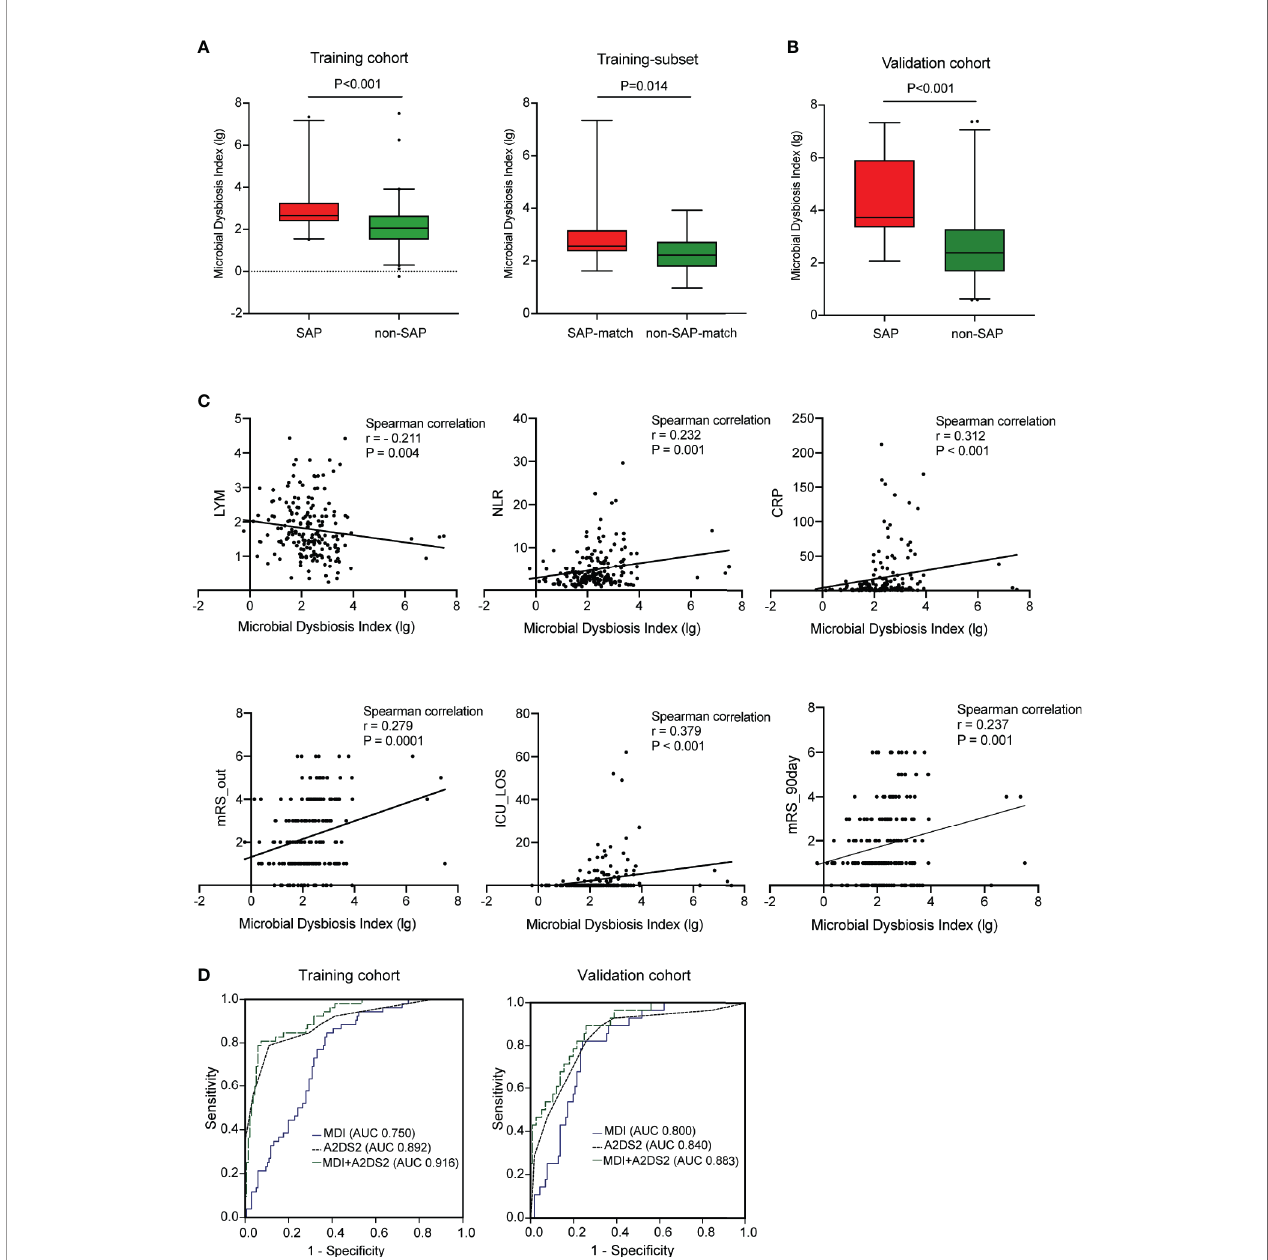
FIGURE 3 | Microbial dysbiosis is associated with SAP. (A) Box plot showing the MDI in the SAP and non-SAP groups in all patients ( A , left) and age- and NIHSS- matched subset ( A , right) in the training cohort. (B) Box plot showing the MDI of the validation cohort. (C) Correlation between MDI and clinical parameters including markers of immunosuppression (LYM), system in fl ammation (NLR, CRP), and outcomes (ICU-LOS, discharged and 90 days- mRS score). (D) Predictive performance of MDI, A2DS2 and the predictive model (A2DS2 plus MDI) for SAP in the training cohort ( D , left) and in the validation cohort ( D , right). Training cohort (n=188); Validation cohort (n=144). AUC, area under the curve; MDI, microbial dysbiosis index; ROC, receiver operating